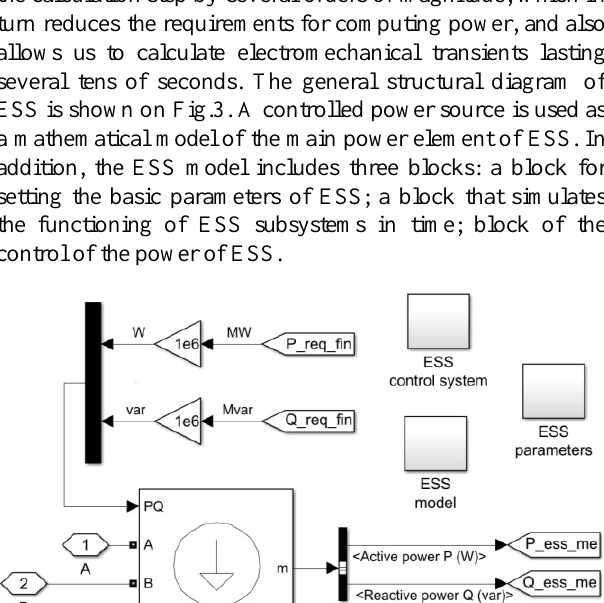
Figure 1. Structural diagram of a mathematical model of an autonomous power system